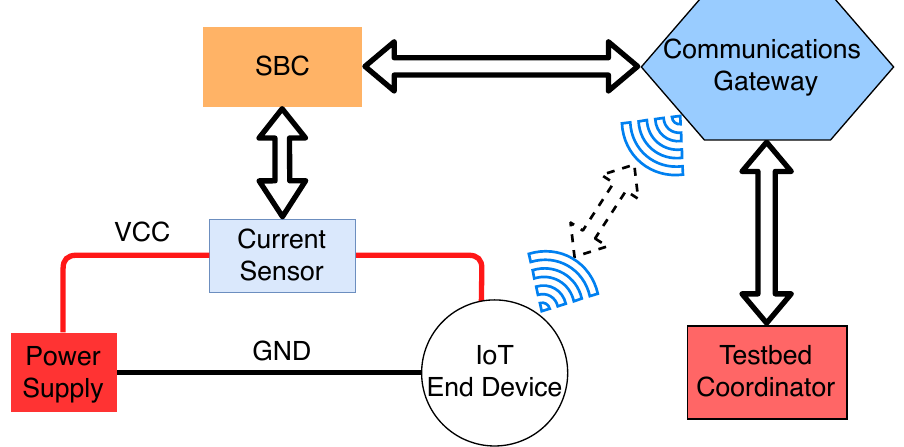
Figure 2. General testbed